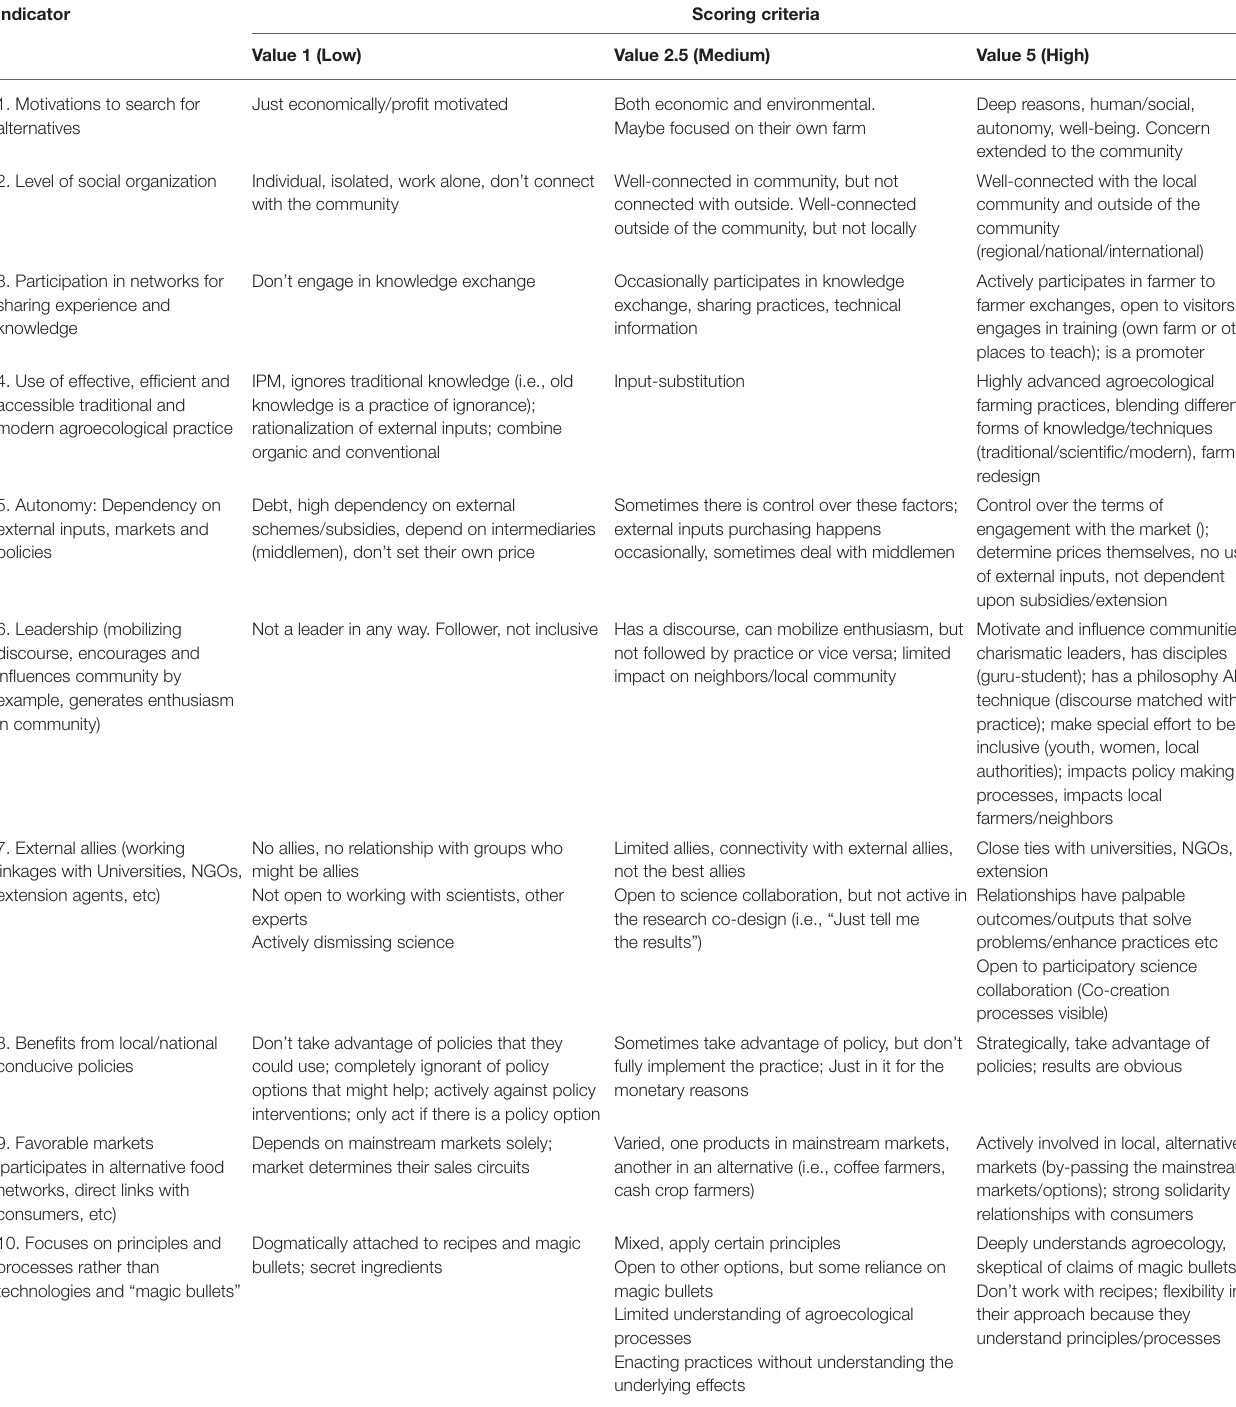
TABLE 2 | Set of ten indicators used as an agroecology amplification assessment rubric.